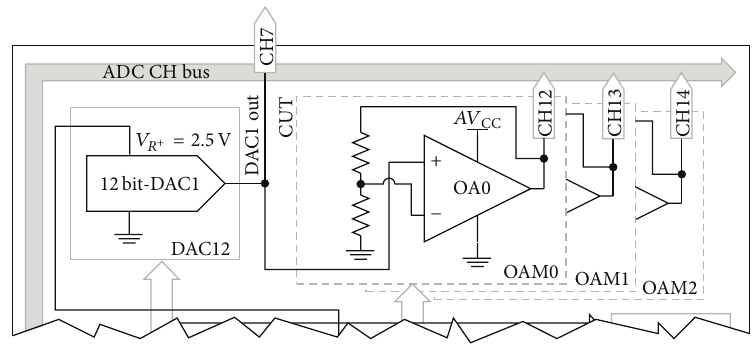
Figure 8: Arrangement for testing mode 4.